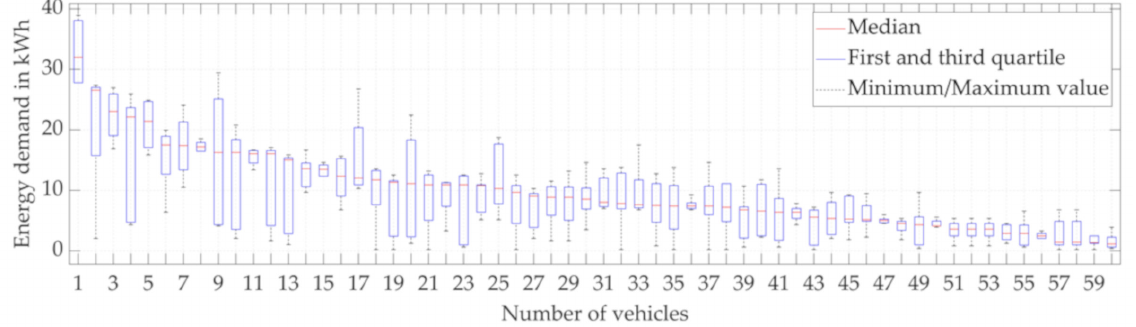
Figure 11. Diagram representing the energy demand for a single trip of each vehicle during operation for one week.